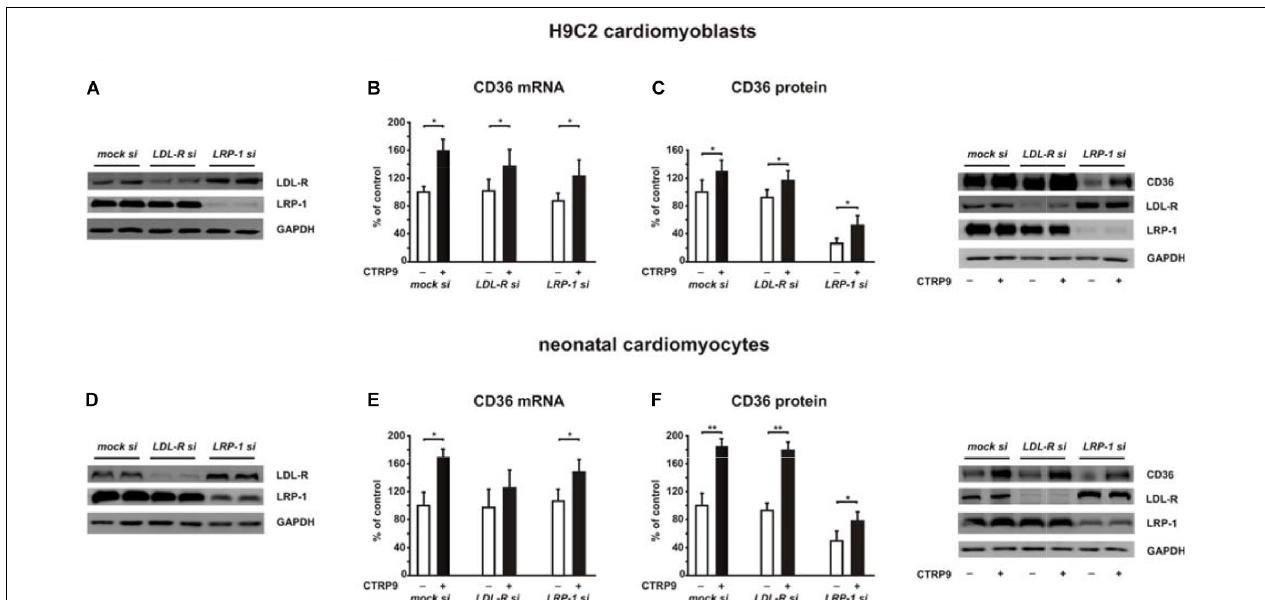
FIGURE 9 | Impact of LDL-R and LRP1 on CTPR9-induced effects on fatty acid metabolism. H9C2 cells (A–C) or neonatal rat cardiomyocytes (D–F) were transfected with siRNA directed against LDL-R, LRP1 or control siRNA (mock). Cells were harvested 48 h after transfection. 24 h after transfection cells were treated with CTRP9 (4 µ g/ml) as indicated. (A,D) Representative Western blots of LDL-R and LRP1 are shown. GAPDH served as a loading control. (B,E) Changes in the mRNA expression of CD36 were analyzed by Real-time PCR. (C,F) CD36, LDL-R, and LRP1 protein expression were analyzed by Western Blotting. Representative Western blots and densitometry of protein data are shown. GAPDH served as a loading control. All data are mean ± SEM, 4 independent experiments, n = 8 per group, * p < 0.05, ** p <